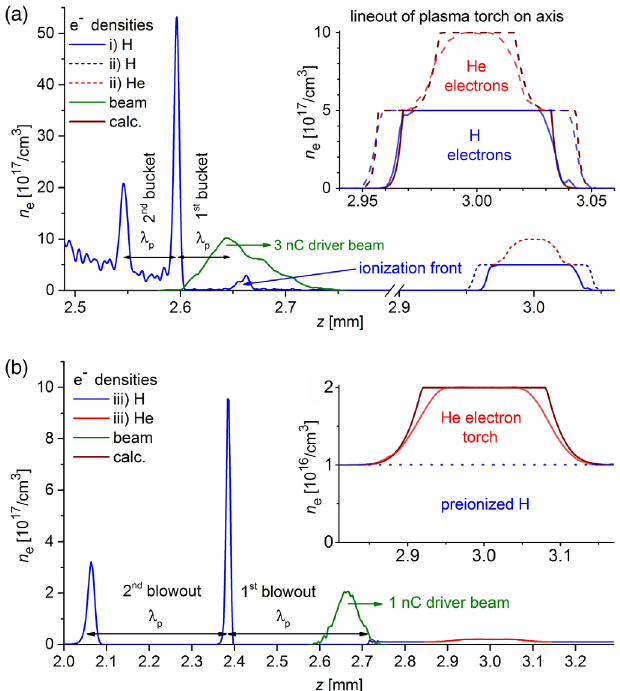
FIG. 1. Experimental setup: An electron beam driver and one or two moderately synchronized laser pulses interact in an under- dense medium with (at least) two species with different ionization thresholds such as hydrogen and helium. One Ti:sapphire laser pulse is focused to intensities of the I ≈ 10 14 – 15 W = cm 2 level in order to generate the localized hydrogen/helium plasma torch in the path of the electron beam driven blowout. In contrast to the self-ionized cases (i) and (ii), for case (iii) another, high-energy fraction of the laser pulse is used to preionize the hydrogen in order to allow for a stronger blowout.